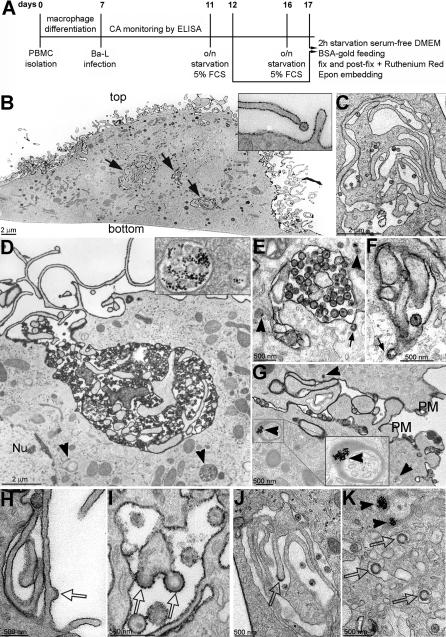
HIV-1 Buds and Accumulates in RR-Stained Domains(A) Flow diagram of macrophage differentiation, infection, and processing for EM. CA, capsid protein.(B) Low magnification profile of an infected MDM displaying RR stain on the cell surface and on seemingly intracellular plasma membrane invaginations (arrows). Note that the bottom surface (indicated as “bottom”) that was previously attached to the substrate is not RR-stained, whereas the top surface is. The inset shows a mature virus particle on the tip of a finger-like plasma membrane protrusion.(C) Collection of RR-stained protrusions with RR-stained mature virus particles.(D) Large cell-surface invagination that is directly connected to the RR-stained cell surface and contains numerous RR-stained virions. The inset shows a multivesicular BSA-gold-filled endosome inside the same cell.(E and F) RR-stained vacuole-like structures harboring virus particles and displaying structures resembling clathrin-coated pits (small arrows). Arrowheads in (E) indicate gold-filled endosomes that are not RR-stained and significantly smaller than the virus-filled structures.(G) RR-stained virus particles accumulating between the RR-stained plasma membranes of two neighboring cells; arrowheads, BSA-gold-filled endosomes. The inset in (G) shows an enlargement of a BSA-gold-filled endosome in the boxed area.(H–K) Virus-budding profiles (open arrows) (H) on the RR-stained cell surface and (I) on a RR-stained cell surface invagination.(J) Early virus bud on the tip of a finger-like protrusion in a vacuolar structure devoid of RR and BSA-gold.(K) Late virus buds on RR-negative membranes next to BSA-gold-filled endosomes (arrowheads). Nu, nucleus; PM, plasma membrane. Bars, 2 μm (B–D) and 500 nm (E–K).